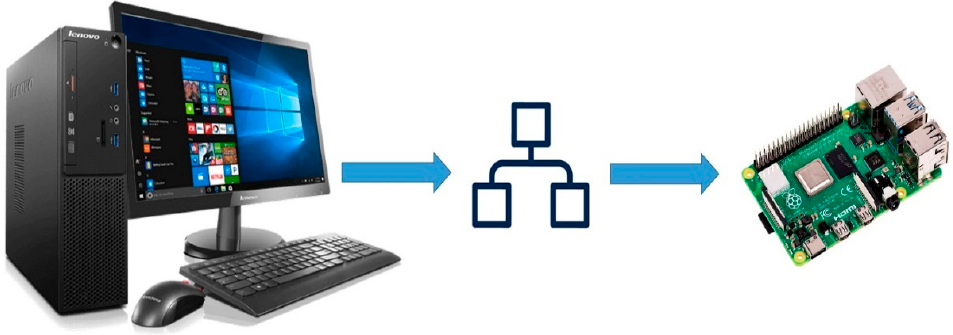
Figure 9. MATLAB-Raspberry Pi 4 Implementation using OMPC and LiberMate